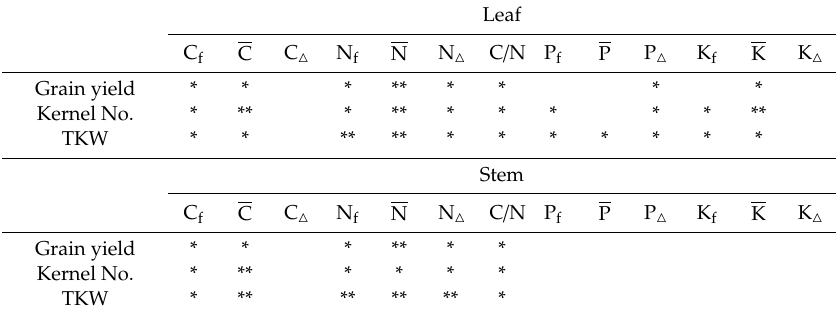
Table 5. The correlation analysis of C, N, P, K content (g plant − 1 ) dynamics in leaf and stem post-flowering, grain yield, kernel number (kernel No.), and thousand kernel weight (TKW).